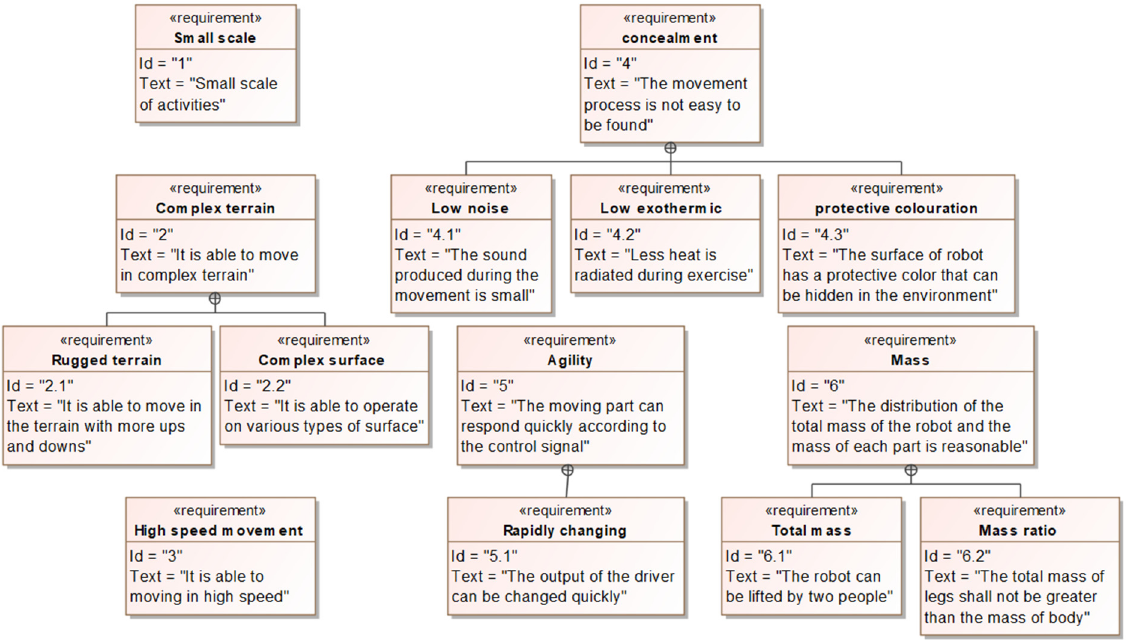
Figure 12. Requirement diagram of the quadruped robot.